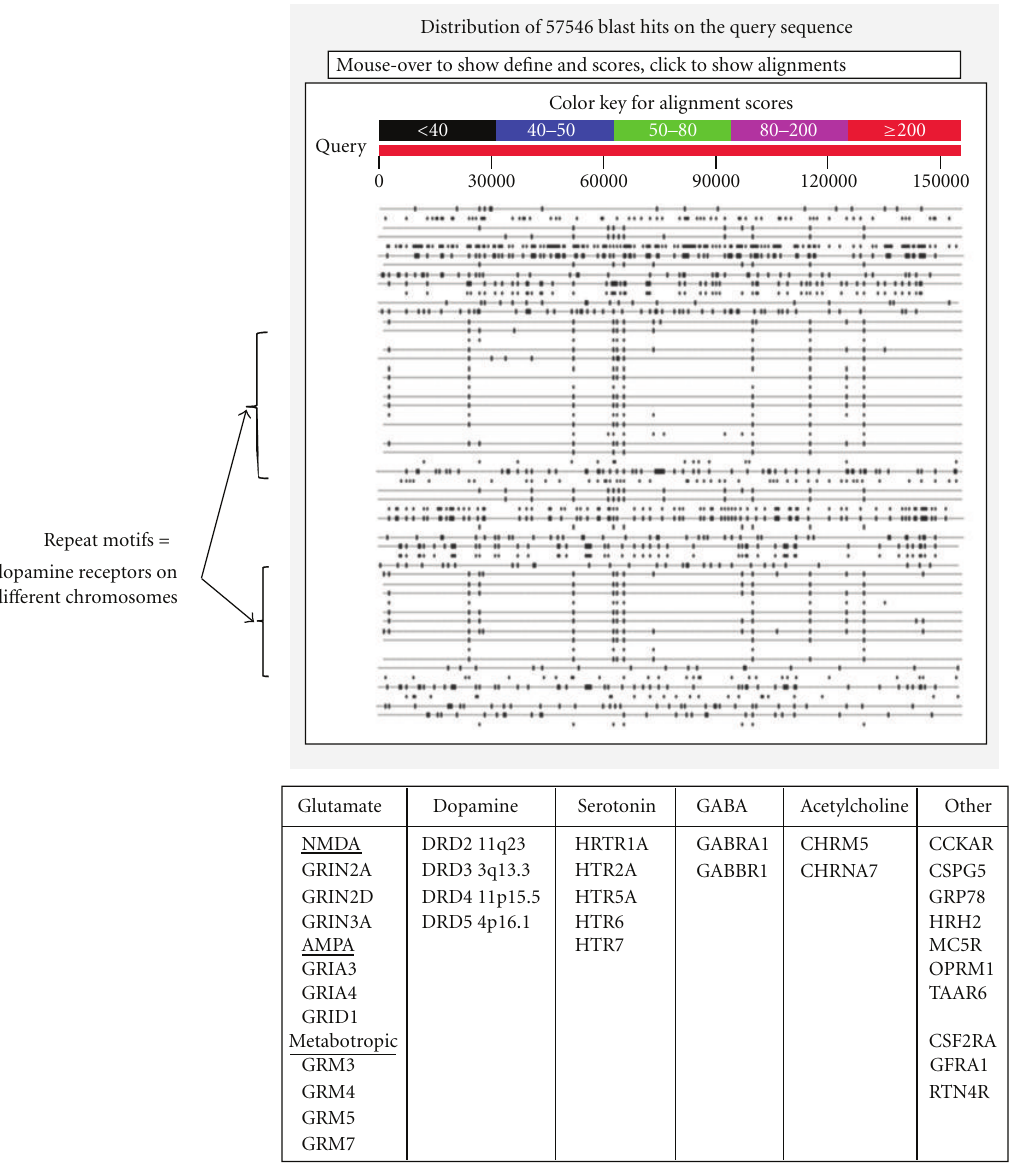
Figure 6: A screen shot of the HSV-2 BLAST results using the filter “dopamine receptor”. The repeated patterns correspond to dopamine receptors on di ff erent chromosomes as shown in Table 1. Homology with glutamate, serotonin, GABA, acetylcholine and other receptors is also